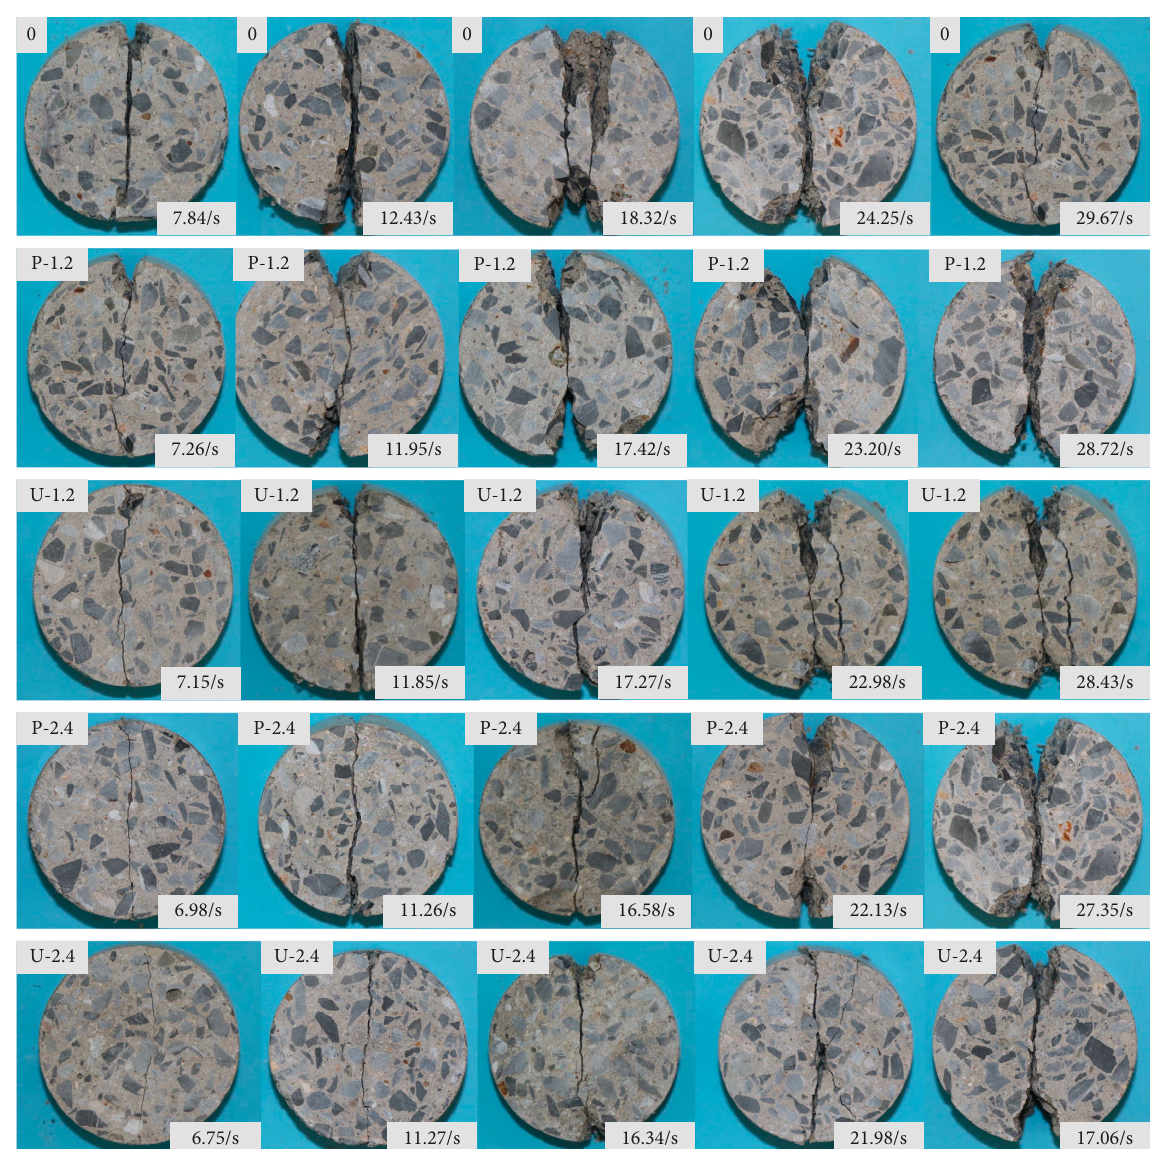
Figure 17: Dynamic collapse of fiber-reinforced concrete in each